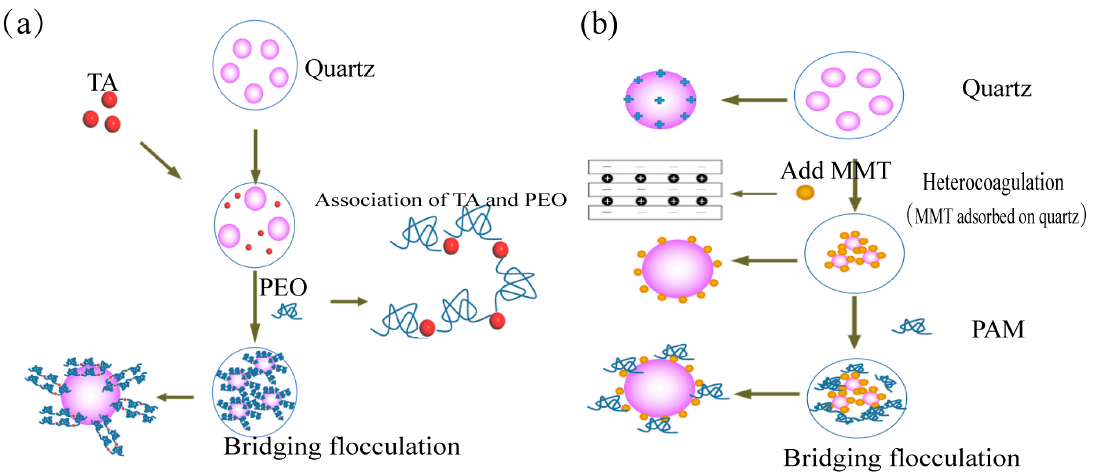
Figure 14. Schematic illustration of flocculation: ( a ) Quartz - TA - PEO; ( b ) Quartz - MMT - PAM.